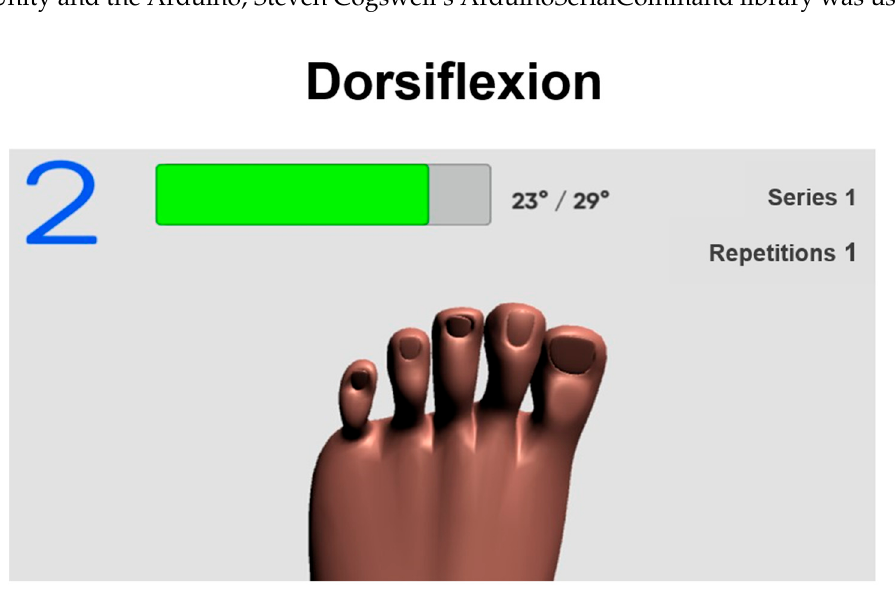
Figure 6. Entity relationship model.